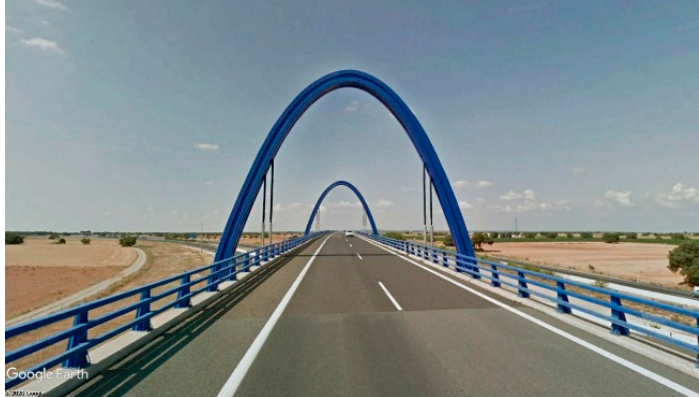
Figure 11. AP-36 highway (photo: Google Earth, Street View).